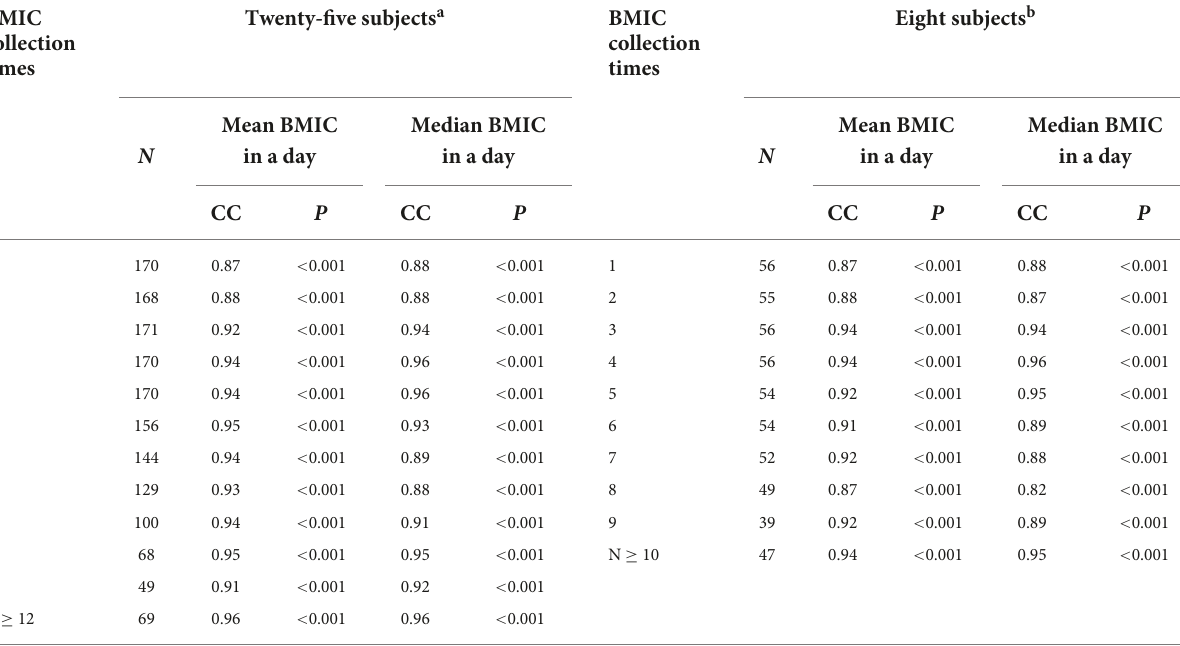
TABLE 4 Estimation of the optimal sampling time of breast milk